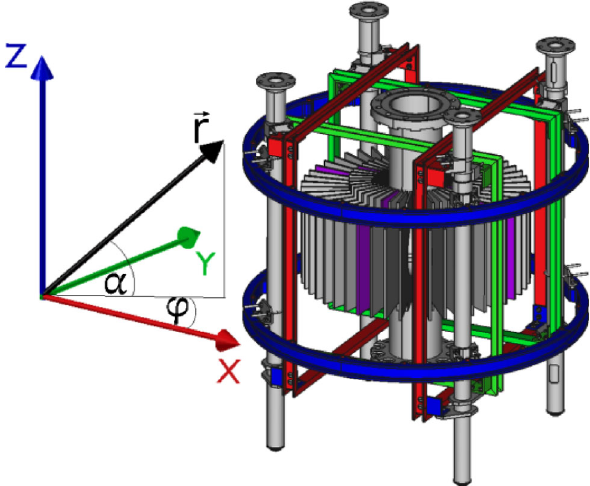
FIG. 1. CAD rendering of the measurement setup consisting of the cavity in the middle, circuit boards measuring the temperature and B-field around it, and three Helmholtz coils. The blue, red, and green coils generate a field in z , x , and y directions respectively. Boards for measuring the magnetic field are high- lighted purple.